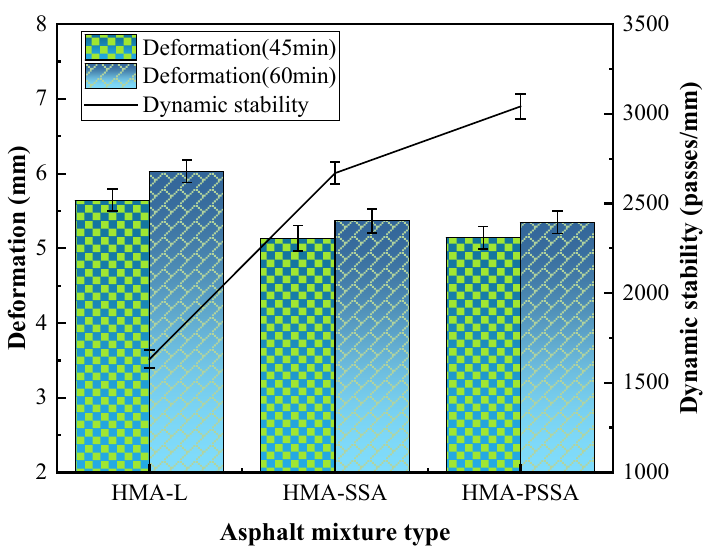
Figure 15. High-temperature stability and permanent deformation test results.